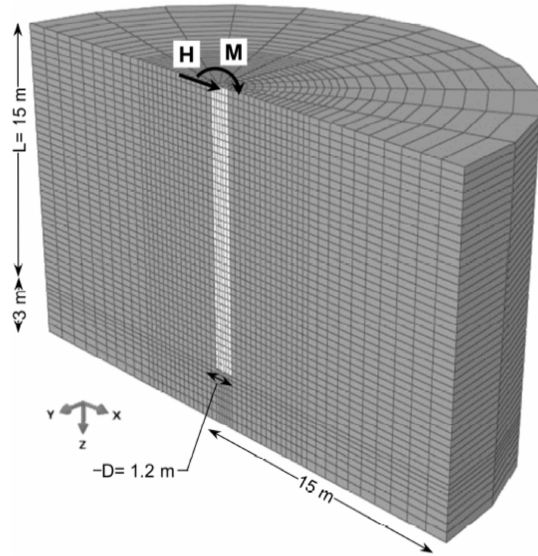
Figure 3. Finite element mesh of the three-dimensional